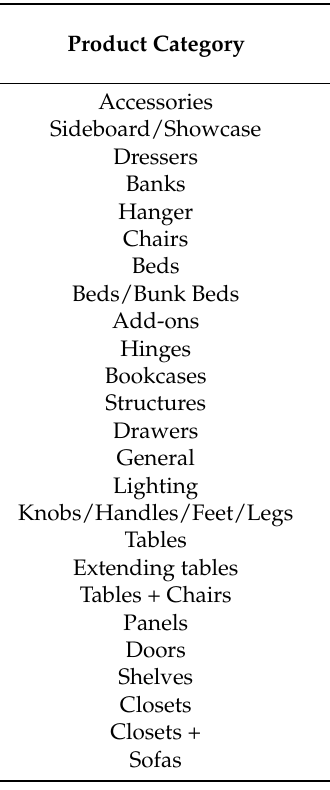
Table 2. Product categories classified by type of